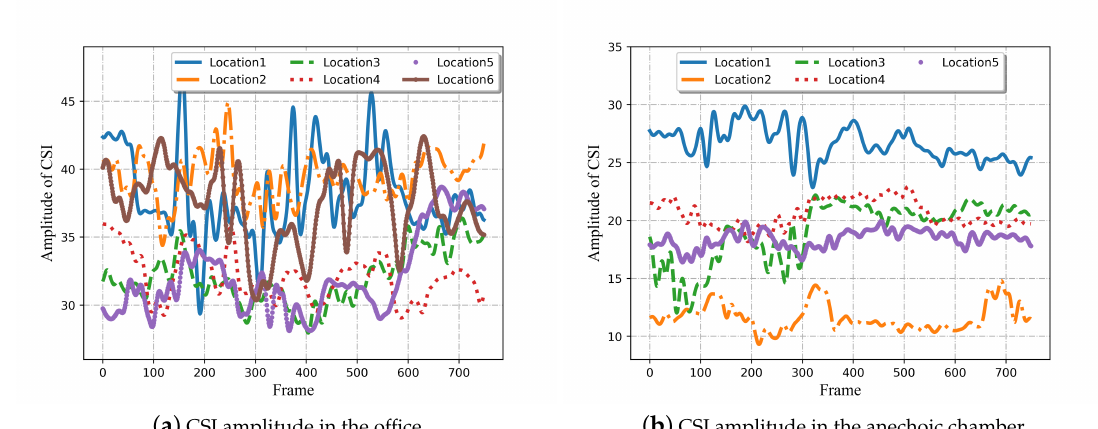
Figure 5. CSI amplitude of the same activity at different locations in two experimental scenes. ( a ) CSI amplitude in the office. ( b ) CSI amplitude in the anechoic chamber. Each curve in each subgraph represents an activity sample at one location.